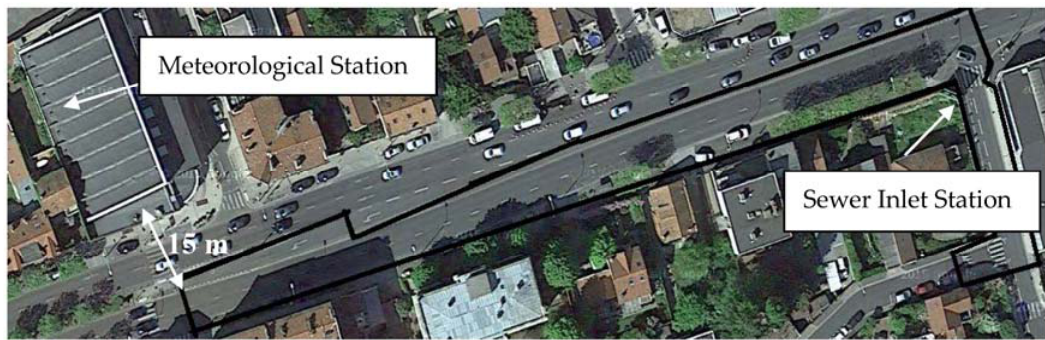
Figure 1. The studied catchment delimited in bold black line. In the image we see the location of the sewer inlet station and the meteorological station insalled at 180 m from the sewer inlet and 15 m of the extremity of the catchment (Photo taken from Google Map@2016).